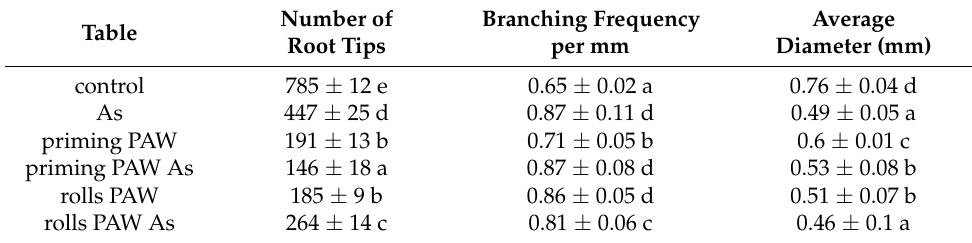
Figure 6. Habitus ( a ) of the maize plants (hybrid Bielik) and roots growth parameters ( b ) after 10 days of hydroponic cultivation as control or pre-treated with PAW (priming PAW and rolls PAW treatments) without and with As. Values (columns for primary root, line for total roots) are means of four replicates ± SD. Different letters denote a significant difference between the treatments. Changes in the root morphology were also confirmed by software analysis (Table 1). Table 1. Maize root (hybrid Bielik) morphological characteristics after 10 days of hydroponic cultiva- tion as control or pre-treated with PAW (priming PAW and rolls PAW treatments) without and with As. Values are means of four replicates ± SD. Different letters denote a significant difference between the